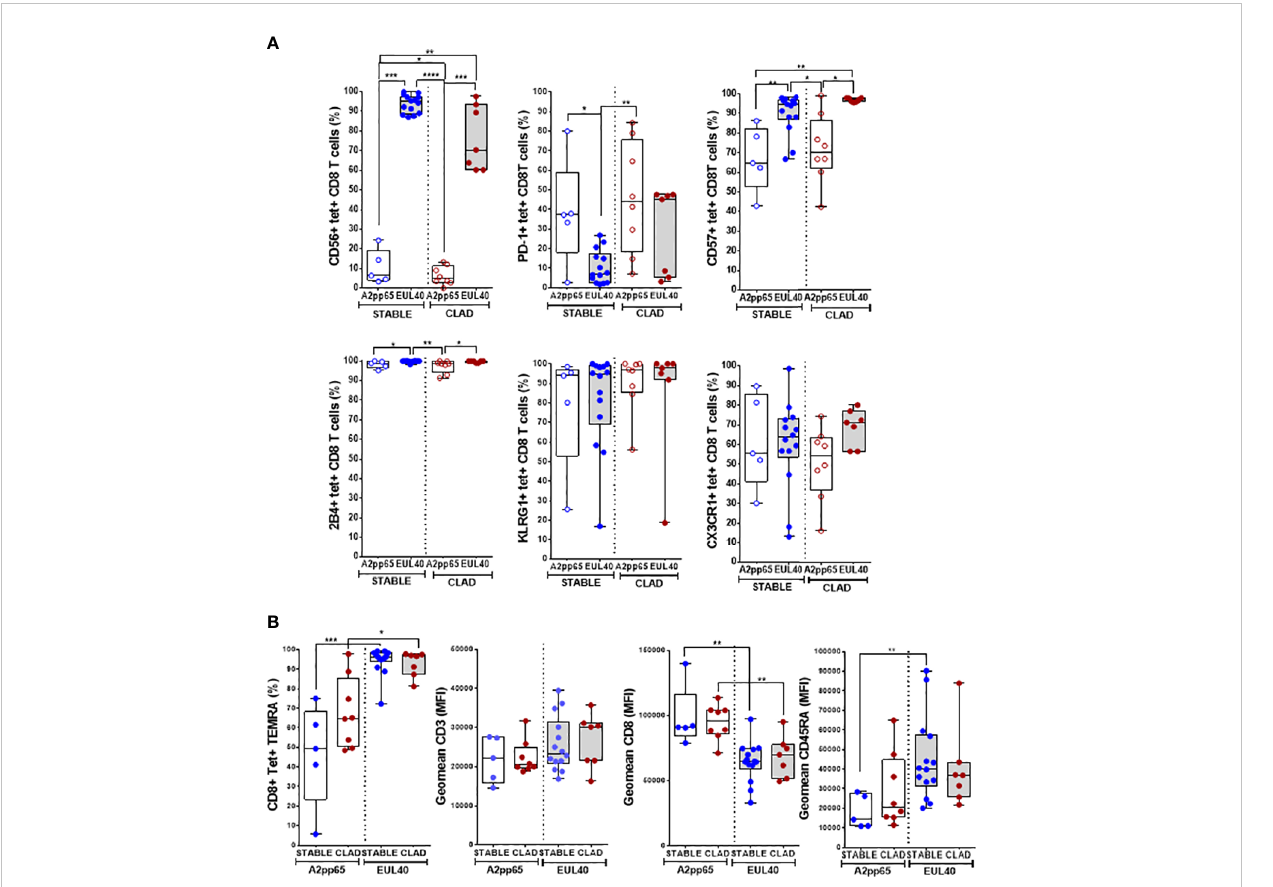
FIGURE 3 Immunophenotype of HLA-EUL40 and HLA-A2pp65 memory CD8 T cells in CLAD versus STABLE LTRs. Immunostaining was performed after a preliminary step of CD94 blocking and by using a panel of mAbs for 11 cell surface markers and HLA tetramer complexes. After fl uorescence acquisition, HLA tet + CD8 T populations were selected as CD3 + CD8 + TCR gd – tetramer + T cells and gated as indicated in Figure S2 to determine the expression of various markers. Analyses are shown in box plots with median and interquartile values. Each dot corresponds to a single,